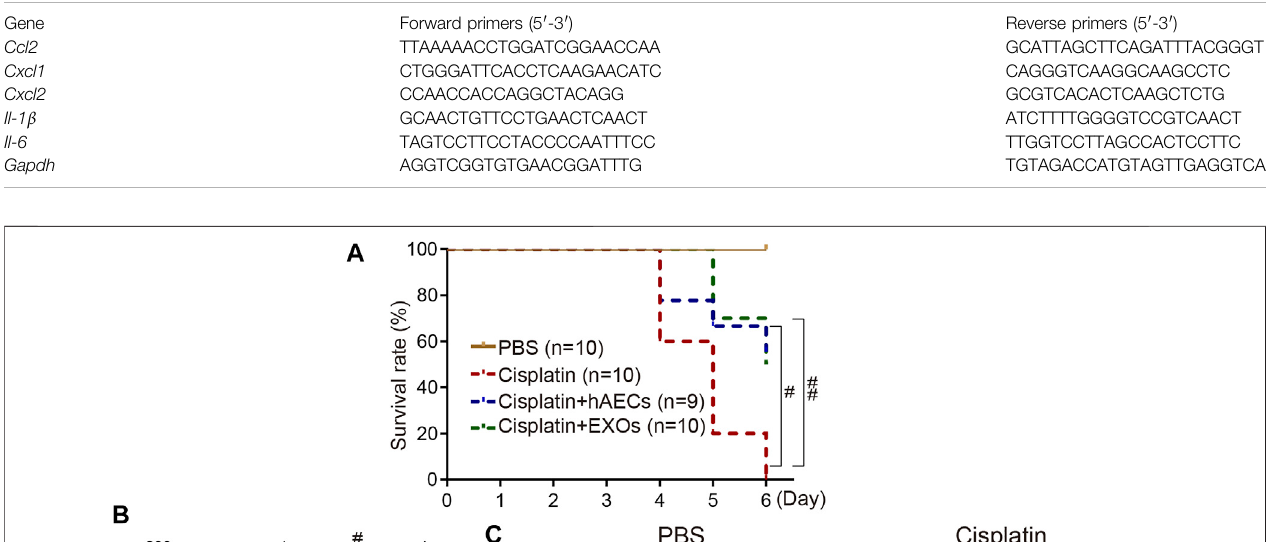
Frontiers in Cell and Developmental Biology |